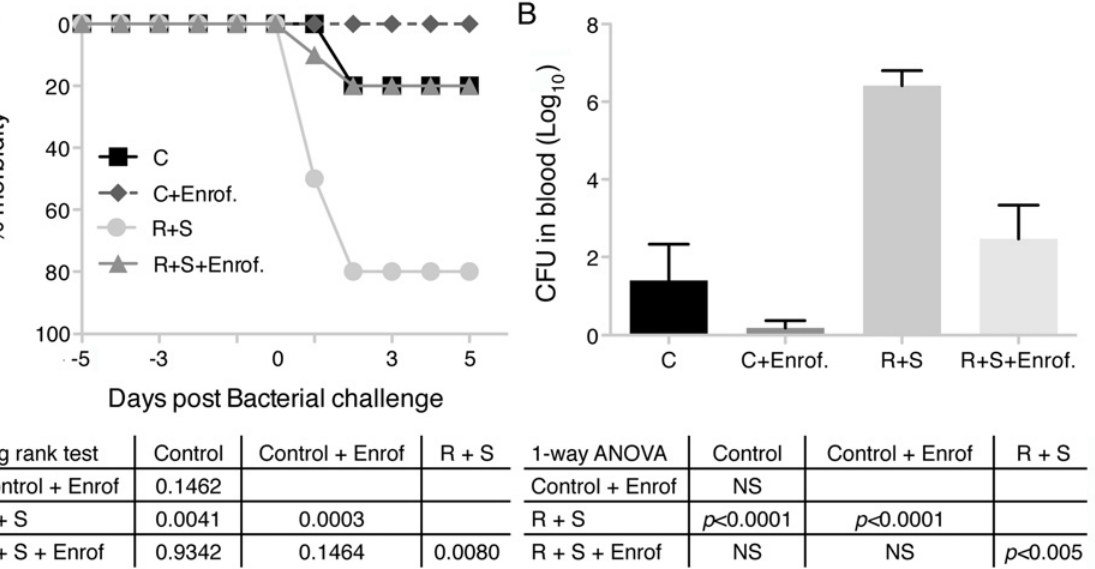
Fig 3. Treatment with enrofloxacin reduces morbidity and increases bacterial clearance in irradiated and hindlimb suspension mice systemically challenged with Pseudomonas aeruginosa . Groups of 10 mice per treatment group were irradiated with 2 Gy of gamma rays and hindlimb suspended or not and injected subcutaneously with either PBS or enrofloxacin (10 mg/kg) every 12 hrs starting 12 hrs before bacterial challenge. All groups were exposed to Pseudomonas aeruginosa by intraperitoneal injection and followed. Morbidity scores (Table 1) were calculated daily (A) and animals were considered morbid if their score increased by 3 points or remained 2 points elevated for more than 24 hrs. C = control, R + S = irradiated + hindlimb suspended. (B) Bacteremia was quantitated 5 days after challenge by diluting and plating blood followed by colony counting. Values are means ± SEM of log 10 of colony- forming units (CFU). One-way ANOVA with Bonferroni ’ s correction for multiple comparisons was used to test statistical significance of changes in CFUs in blood. Statistical significance of Kaplan-Meier curves was measured by Mantel-Cox log rank